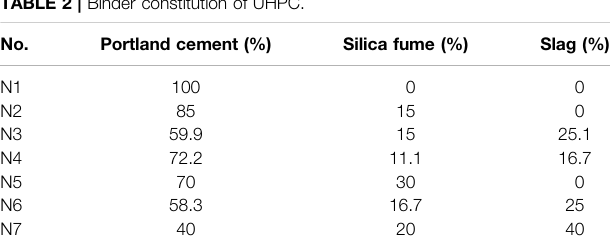
TABLE 2 | Binder constitution of UHPC.